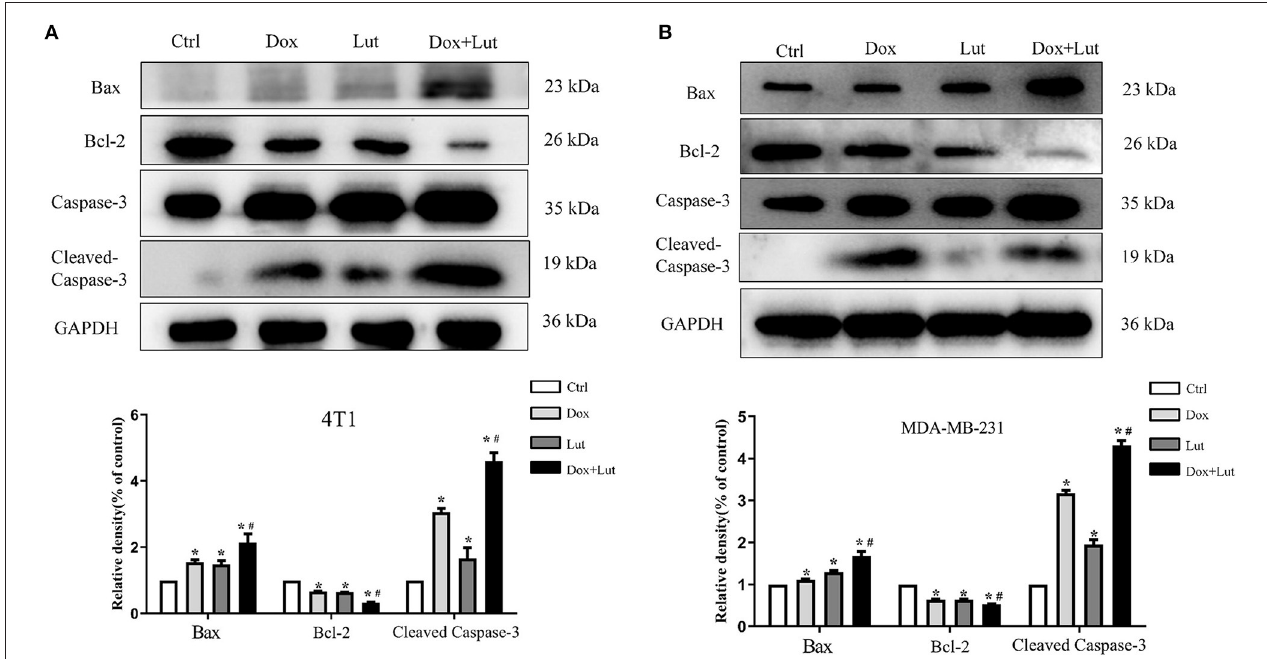
FIGURE 9 | Lut promotes Dox-induced cell apoptosis via the Bax/Bcl-2/Caspase-3 pathway in TNBC cancer. Western blot images of Bax, Bcl-2, and Cleaved Caspase-3 expression in 4T1 (A) and MDA-MB-231 (B) cells after treatment with Dox (2 µ M) or Dox added with Lut (40 µ M) at the indicated concentrations for 24h. Quantification of protein expression is shown below the Western blots. * P < 0.05 compared with control group. # P < 0.05 compared with Dox group.